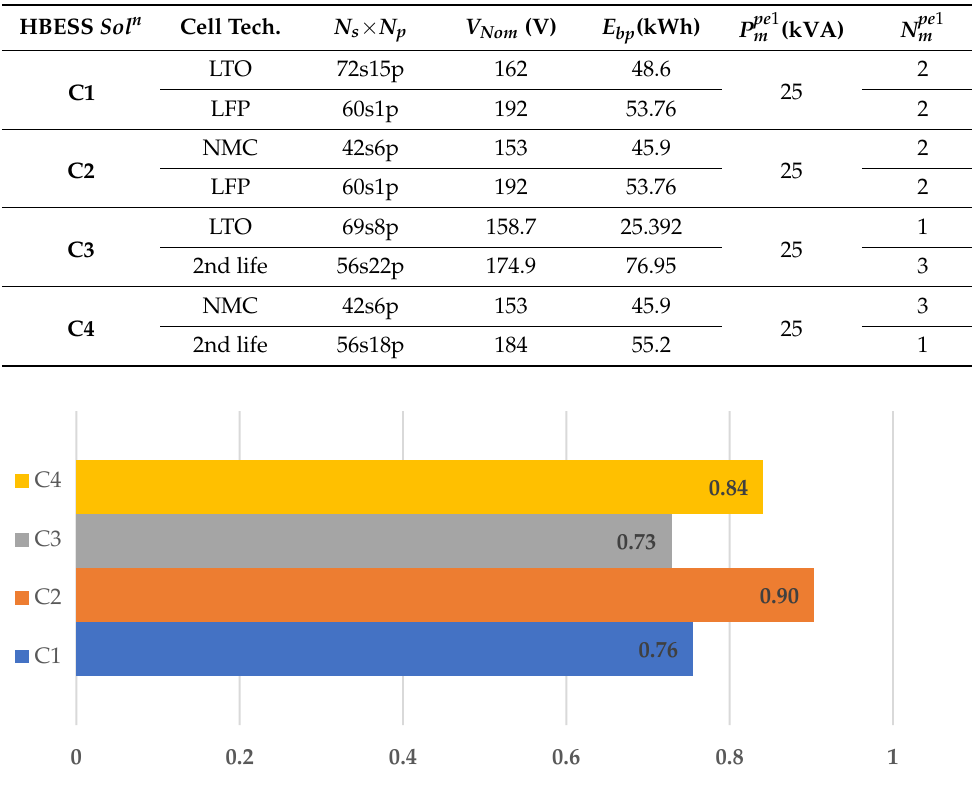
Figure 11. Normalized values of selection criterion applied to saved best optimal Pareto fronts.